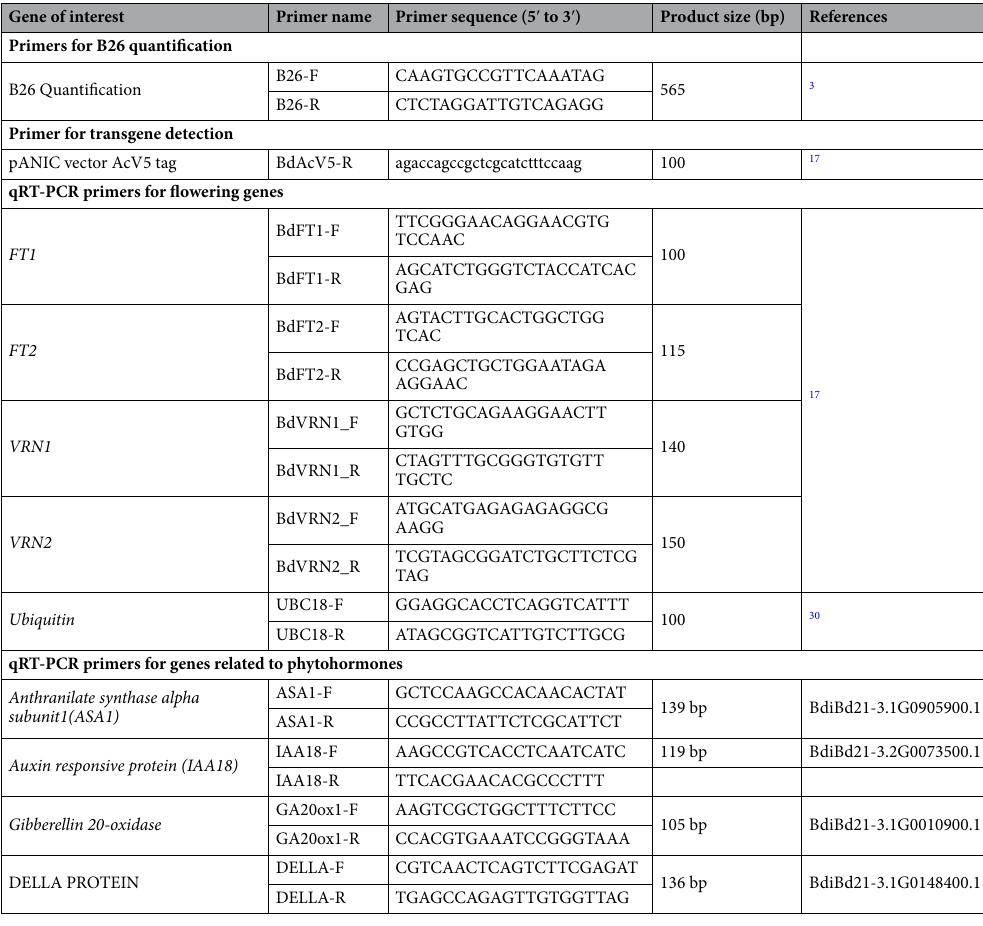
performed as described in Gagne-Bourque et al . 3 . To calculate the quantity of bacterial DNA in inoculated roots and leaves, Cq (Cycle quantification) values of plant DNA were correlated with Cq values in the standard curve. Moreover, for reliability of the designed method, correlation coefficient and the amplification efficiency were calculated from the formula X o = E AMP (b-Cq) = 10 (Cq-b)/m)) , where X o = initial reaction copies, E AMP = Exponential amplification, b = y-intercept of the standard curve (log 10 of copies), m = slope of standard curve. Phytohormone analysis. To determine the effect of inoculation on phytohormones, endogenous levels of plant phytohormones including auxin, cytokinin, gibberellins and abscisic acid was measured using the modi- fied protocol of Li et al . 51 . Inoculated and control roots of Bd21-3, transgenic lines; UBI:FT1 and UBI:VRNI1 from Experiment 2 were subjected to phytohormone analysis after 28dpi. Root samples were crushed in liquid nitrogen. Samples were sent in triplicates to The Metabolomics Innovation Centre, UVic-Genome BC Proteom- ics Centre, Victoria, BC, Canada. Briefly, 100 mg of each sample was precisely weighed into a 2-mL safe-lock Eppendorf tube. 4 µL of 5% formic acid in water per mg of raw tissue and two 4-mm stainless steel balls were added. The sample was homogenized at a shaking frequency of 30 Hz on a MM 4000 mixer mill for 1 min three times. Methanol, at 16 µL per mg raw tissue was then added. The sample was homogenized again for 1 min three times, followed by sonication in an ice-water bath for 5 min and centrifugal clarification at 21,000 g and 10 °C for 10 min. The clear supernatant was collected for the analysis of auxins, cytokinin, gibberellins and abscisic acid. Phytohormones were analysed with UPLC- multiple-reaction monitoring (MRM) mass spectrometry on an Agilent 1290 UHPLC coupled to an Agilent 6495B QQQ mass spectrometer equipped with an ESI source which was operated in the negative-ion mode. LC separation was carried out on a C18 UPLC column (2.1 × 150 mm, 1.8 µm). Concentrations of the detected compounds in the sample solutions were calculated by interpolating the constructed linear-regression calibration curve with the measured analyte-to-internal standard peak area ratios. CT scanning of wild type Bd21‑3 and transgenic lines. The total root volume of inoculated and non- inoculated wild accession Bd21-3, transgenic lines UBI:FT1 and UBI:VRN1 grown in magenta boxes were com- pared by performing macro CT- scanning at 28 dpi. The root systems were scanned using macro-CT scanning with the Canon CT Aquilion Prime SP at the CT Scanning Laboratory for Agricultural and Environmental